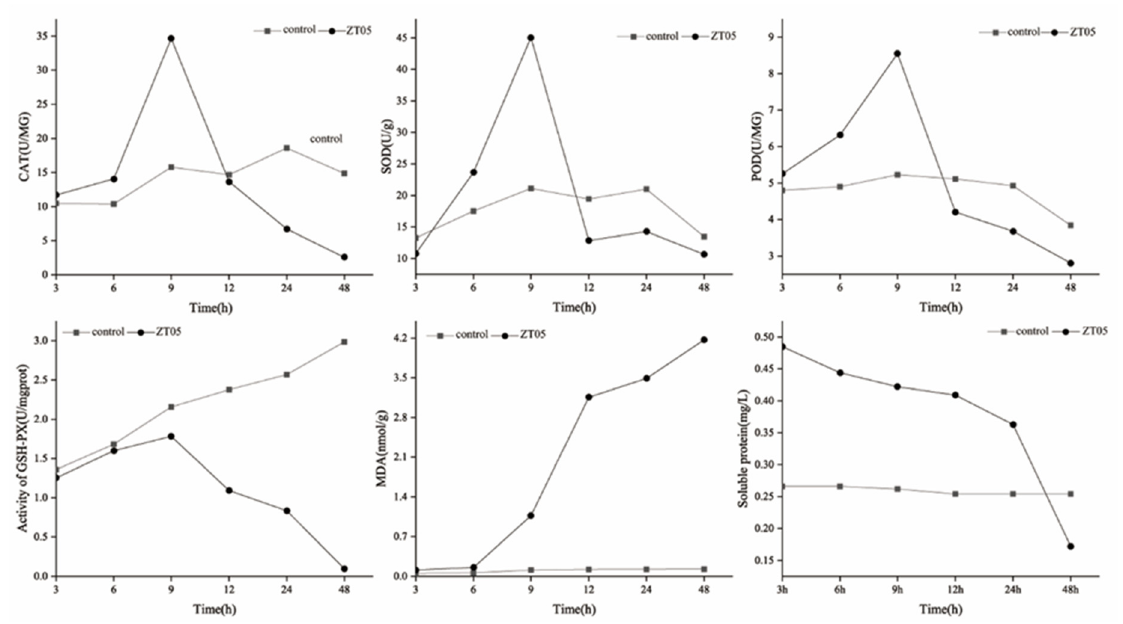
Figure 4. Effect of nonvolatile metabolites on the enzyme activity of R. solani (Control, R. Solani mycelium soaking in 20% Tween 80 solution and ZT05, R. Solani mycelium soaking in 20% nonvolatile metabolites solution of T. virens ZT05).